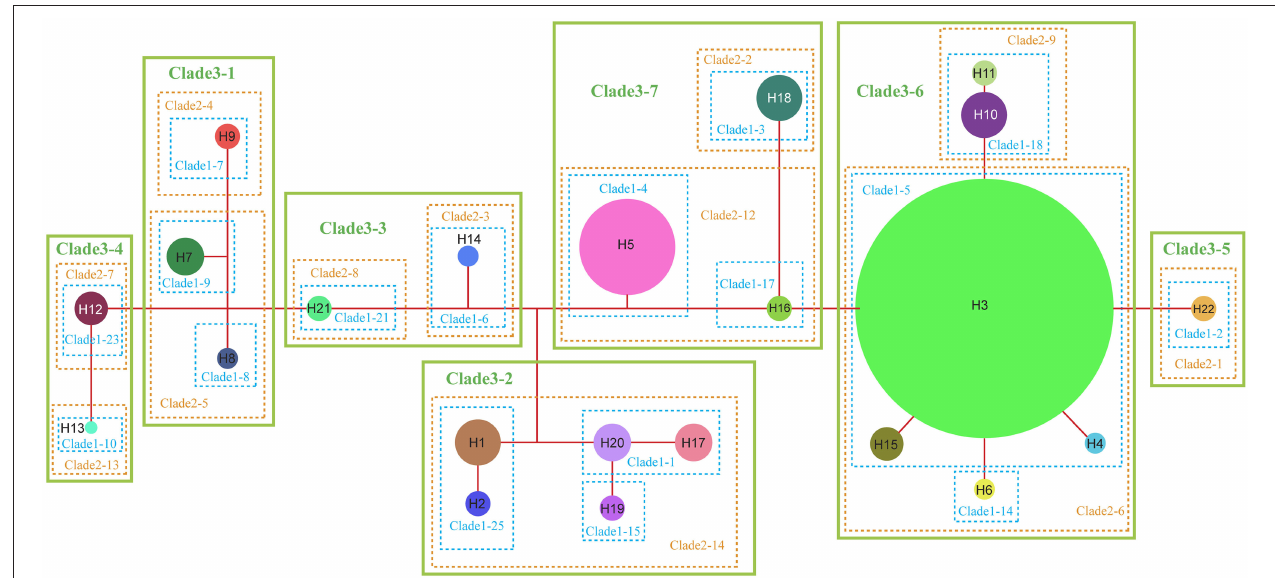
FIGURE 5 | Nested cladogram of the chloroplast haplotypes (H1–H22) of R. chinensis var. spontanea and R. lucidissima complex. Circles with numbers denote haplotypes and their sizes are proportional to the observed frequencies of the haplotypes. Dots represent putative haplotypes. Each branch represents one mutation.